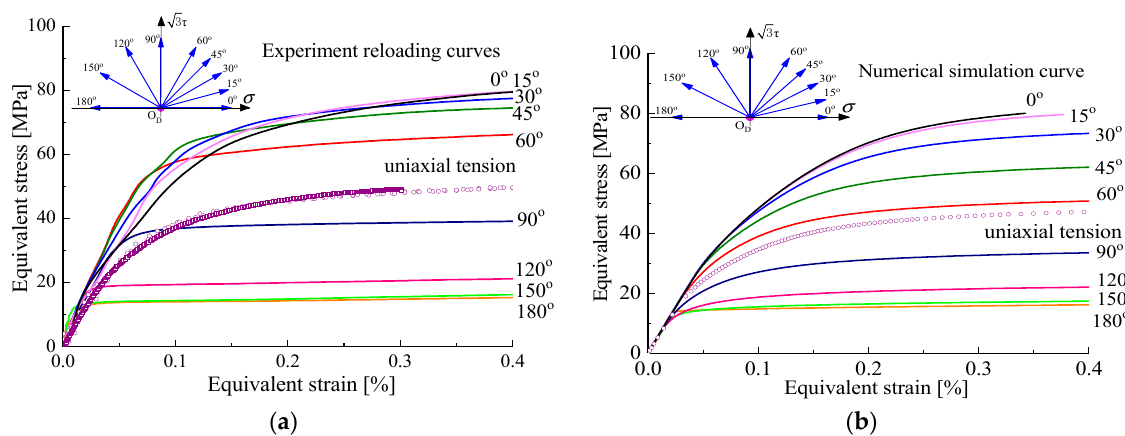
Figure 8. The strain-hardening curves under different tension–torsion reloading paths unloaded from the hysteresis loop D ( − 0.3%) to O D after 30 pre-cycles by test and crystal plasticity simulation: ( a ) the experimental strain-hardening curves; ( b ) the simulated strain-hardening curves.